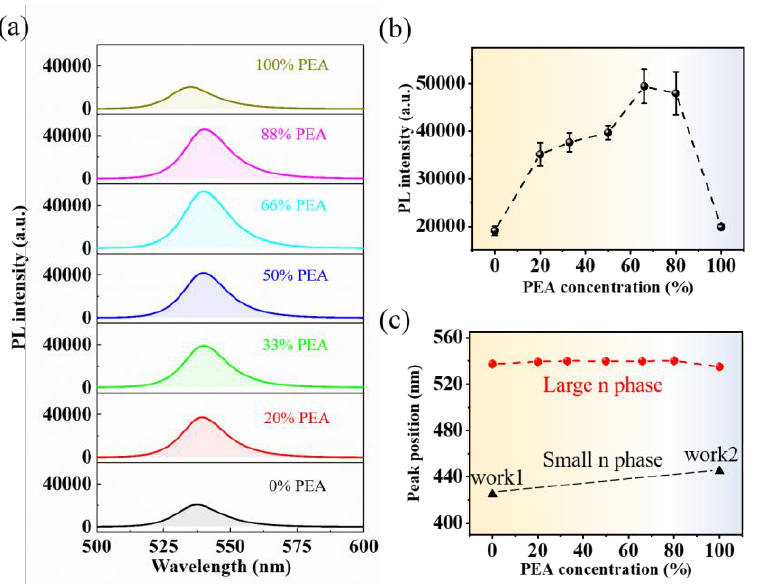
Figure 2. ( a ) PL spectra of mixed organic bulky spacer cations RPP films (at room temperature). ( b ) The correlation between the PL intensity and the PEA concentration in the mixed organic bulky spacer cations. ( c ) The correlation between the PL peak position and the PEA concentration [13,18].